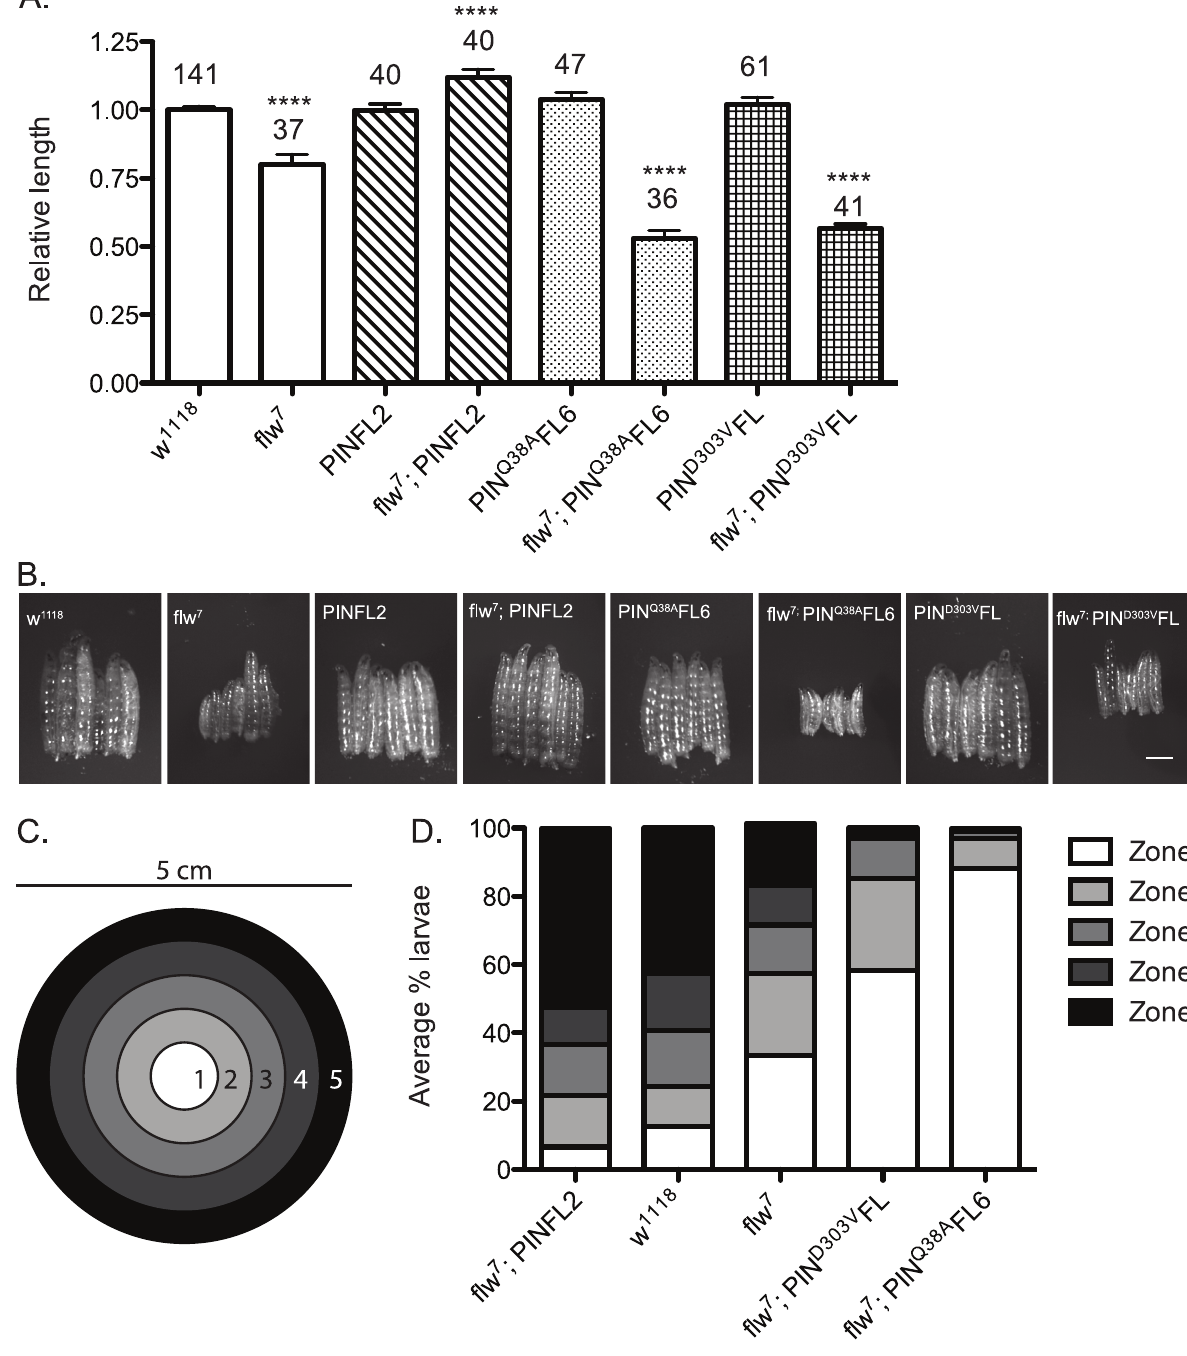
Figure 5. Moderately elevated expression of wild-type PINCH rescues the size and motility defects of flw 7 mutants. A) The lengths of four-day-old larvae were measured, normalizing to the mean of a parallel w 1118 control. Mean 6 SEM for each genotype is shown, with the number of animals measured (n) shown above the bar on the graph. **** indicates p , 0.0001 compared to the w 1118 control. B) Representative phase contrast images of six L3 larvae of the indicated genotypes. Scale bar=1 mm. C) The larval motility assay uses a 5 cm grape agar plate divided into zones as shown. D) The average percentage of larvae located in each zone at the end of the motility assay is plotted for the indicated genotypes, arranged in order of decreasing motility. doi:10.1371/journal.pgen.1003406.g005 not alter the normal attachment of the VIS muscles (Figure S5). copy of the wild-type PINCH-Flag transgene (Figure 6C, 6F). However, flw mutants show frequent VIS muscle detachment Notably, hypercontraction, evidenced by areas of saturated Zasp- GFP signal (Figure 6B–6E, asterisks), is still frequently observed in (Figure 6B, 6F) that is partially rescued by expression of a single